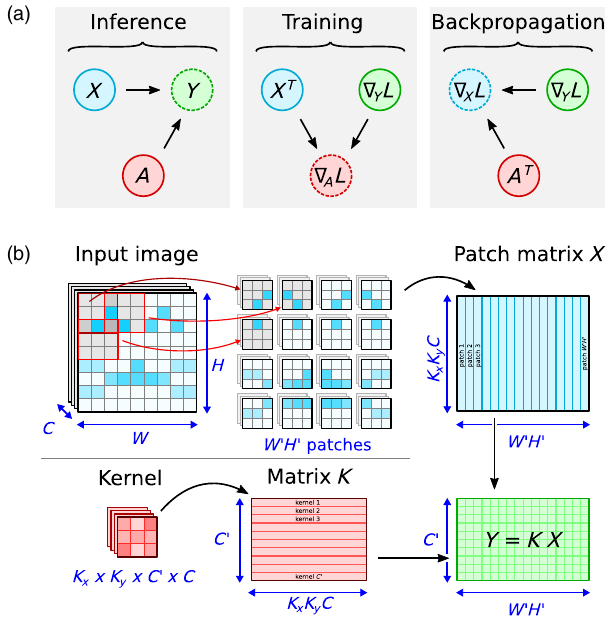
FIG. 7. Applications of optical GEMM. (a) Required matrix operations for inference, training, and backpropagation in a deep neural network. (b) Patching technique to recast a con- volution ( K x ¼ K y ¼ 3 , s x ¼ s y ¼ 2 shown) as a matrix-matrix